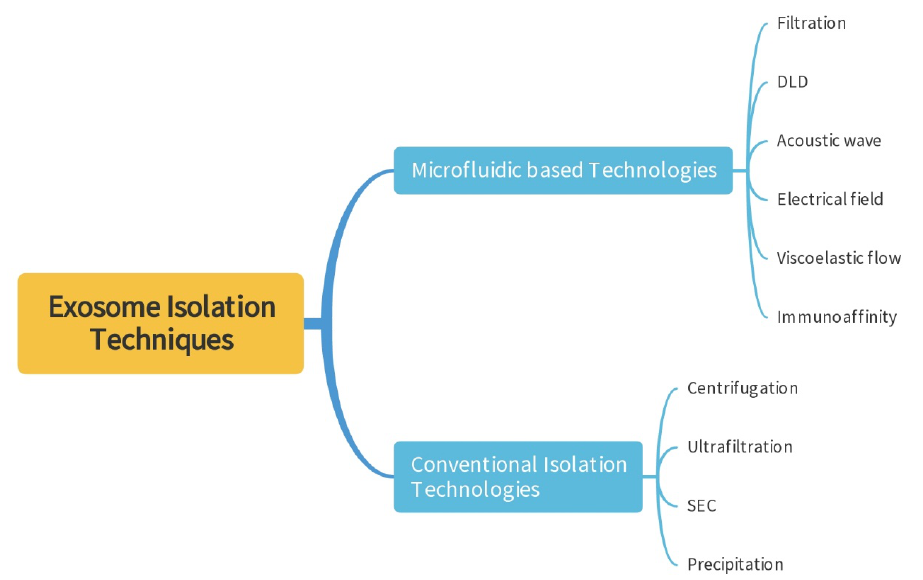
Figure 2. Schematic summary of techniques for exosome separation.